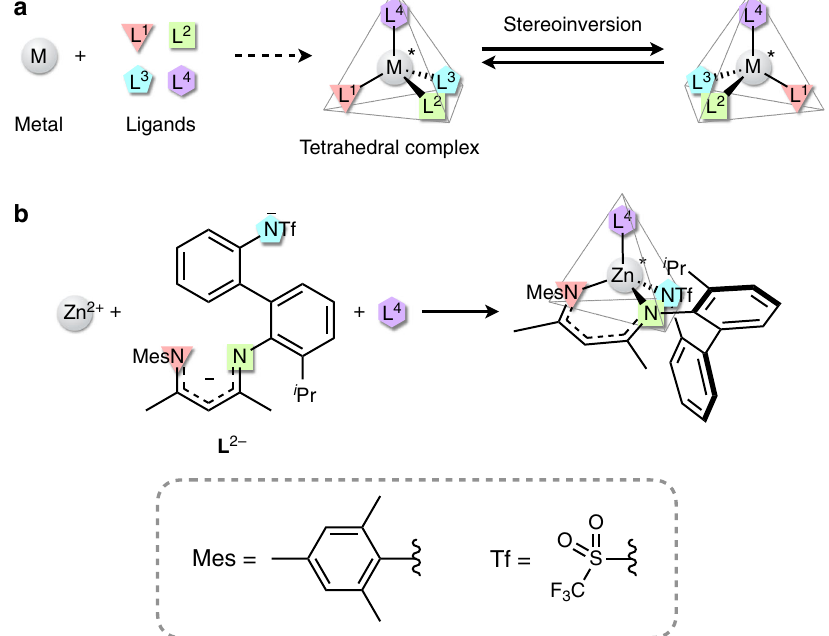
Fig. 1 Design for a chiral tetrahedral metal complex with a con fi gurationally stable metal centre. a Construction of a chiral tetrahedral metal complex using four different monodentate ligands and stereoinversion between its enantiomers. b Construction of a chiral tetrahedral zinc complex with L 2 −